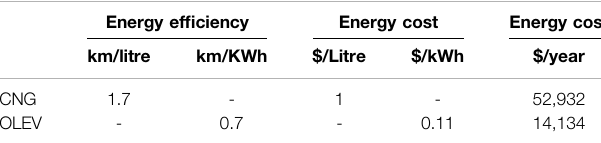
TABLE 10 | Cost analysis of OLEV with CNG (Suh and Dong,